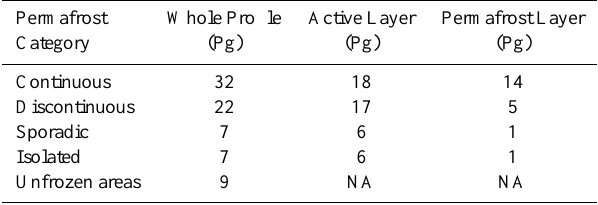
Table 2. Soil organic carbon stocks in different depth intervals and permafrost zones across Alaska (NA=not applicable).